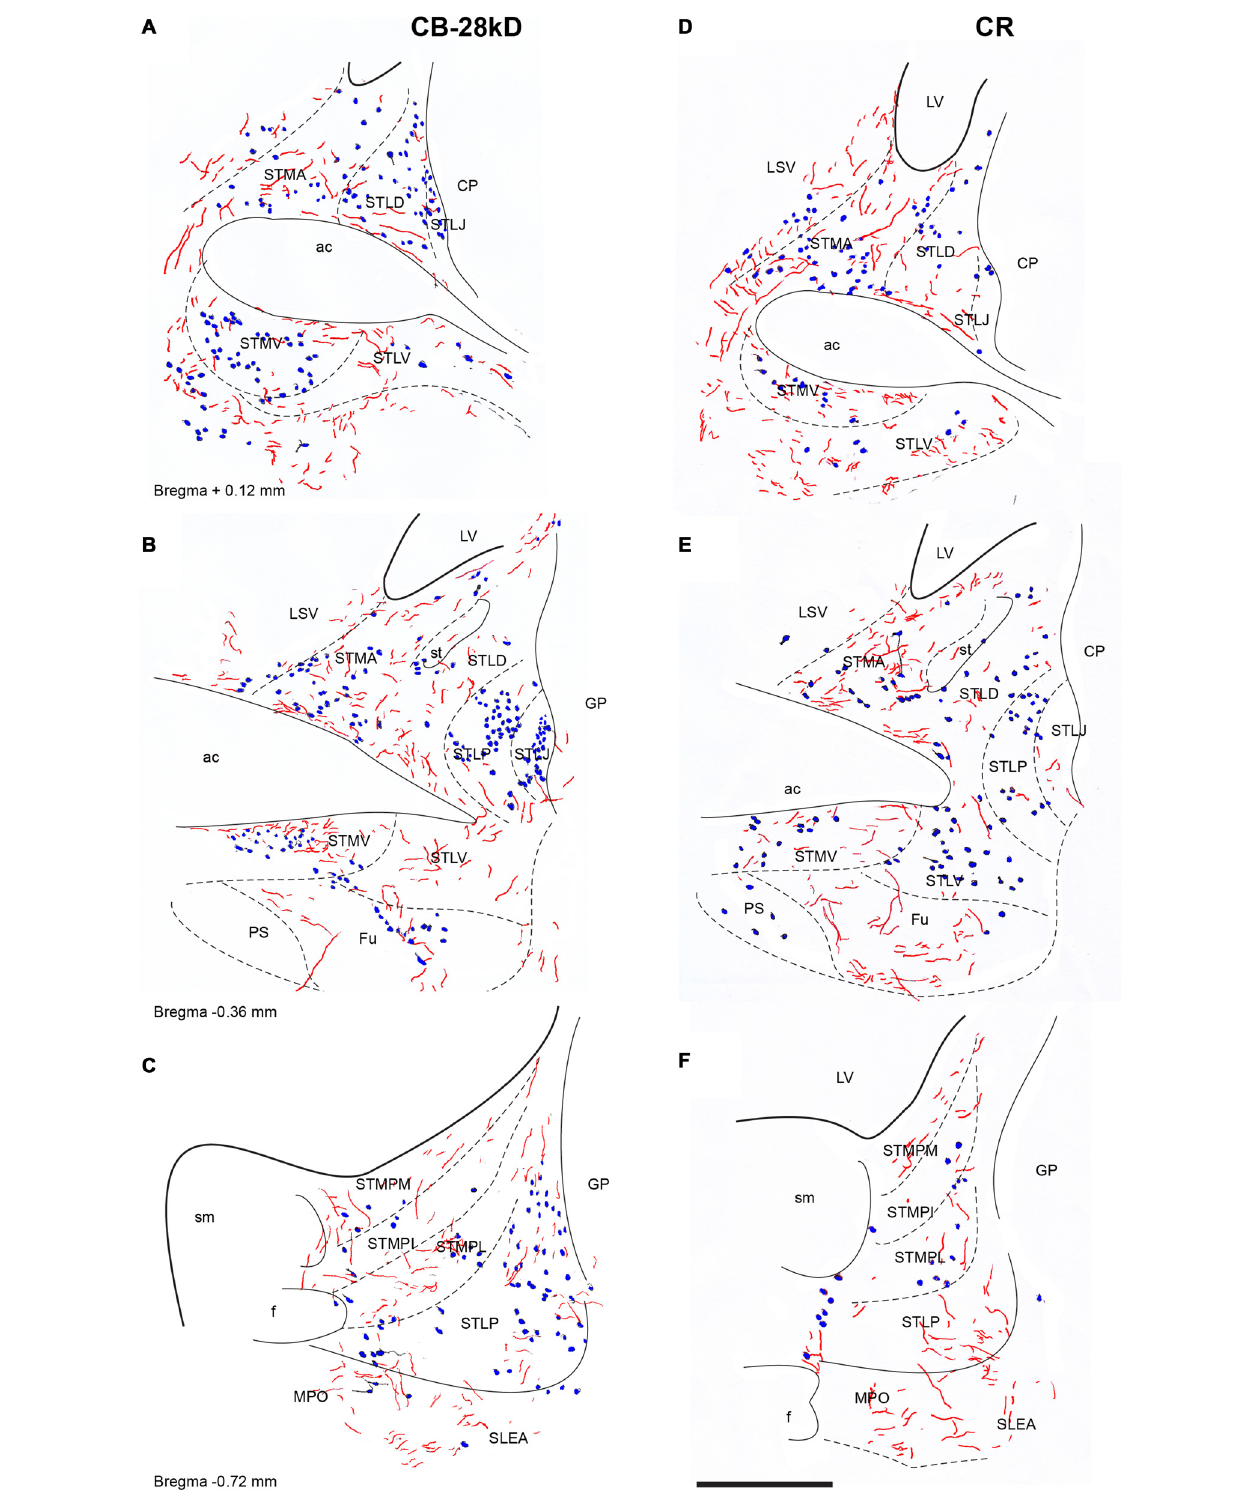
FIGURE 8 | Distribution of relaxin-3-positive fibers in the nuclei of the ST relative to the distribution of CB-28kD-positive neurons (A,C,E) and CR-positive neurons (B,D,F) . Calibration bar 250 µ m.